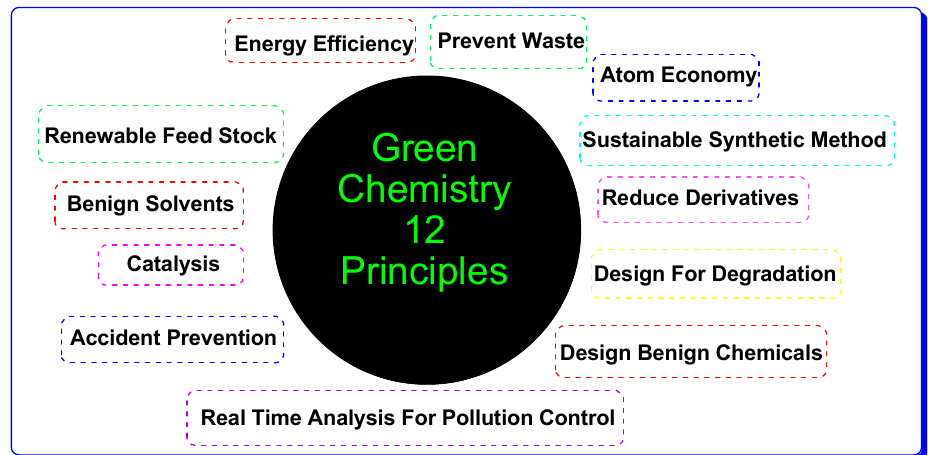
Figure 1. Twelve principles of green chemistry.